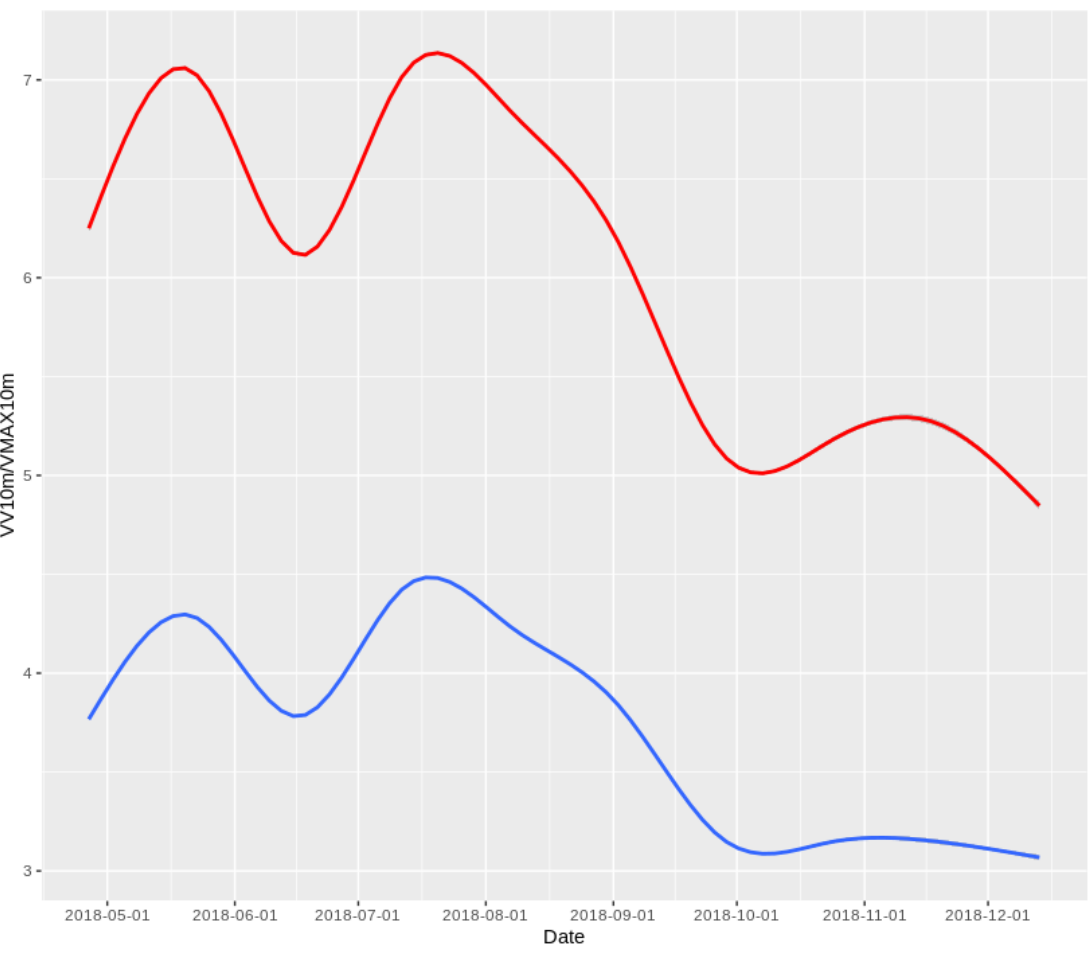
Figure 2. Smoothed (using GAM) evolution of VMAX10m (Maximum wind speed in red, upper part) and VV10m (averaged wind speed in blue, lower part) during the sampled